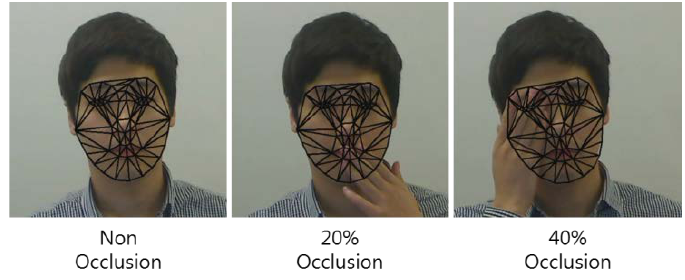
Figure 7. Robust fitting of DB-ASM against several occlusion cases.